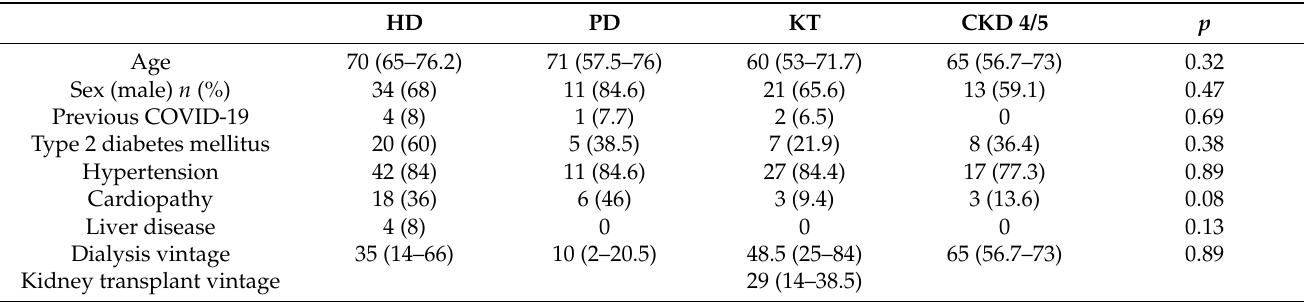
Table 1. Sociodemographic characteristics and clinical profile.